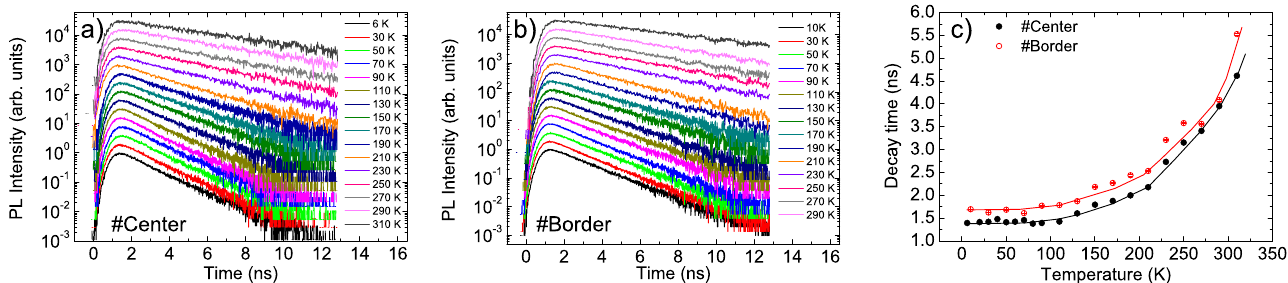
Figure 4. Temperature dependence of the PL relaxation dynamics at the #Center ( a ) and #Border ( b ) points. The data were normalized to the peak values and vertically scaled for clarity. ( c ): Temperature dependence of the PL decay time at the two investigated points (the lines are for visual